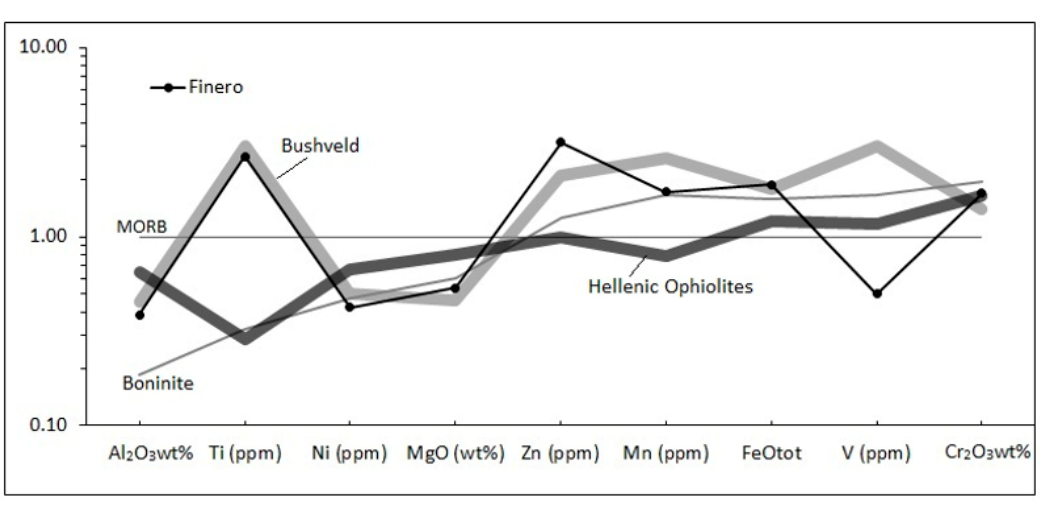
Figure 7. Trace elements pattern in chromites of the Finero Complex, normalized to MORB composition [41]. Podiform chromite pattern is from Hellenic ophiolites [43]. Stratiform chromite pattern is from Bushveld chromites [42].